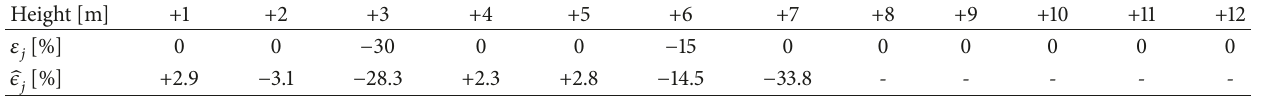
Table 18: Damage estimation in case of 4 repeated tests using 4 sensors, I iteration.